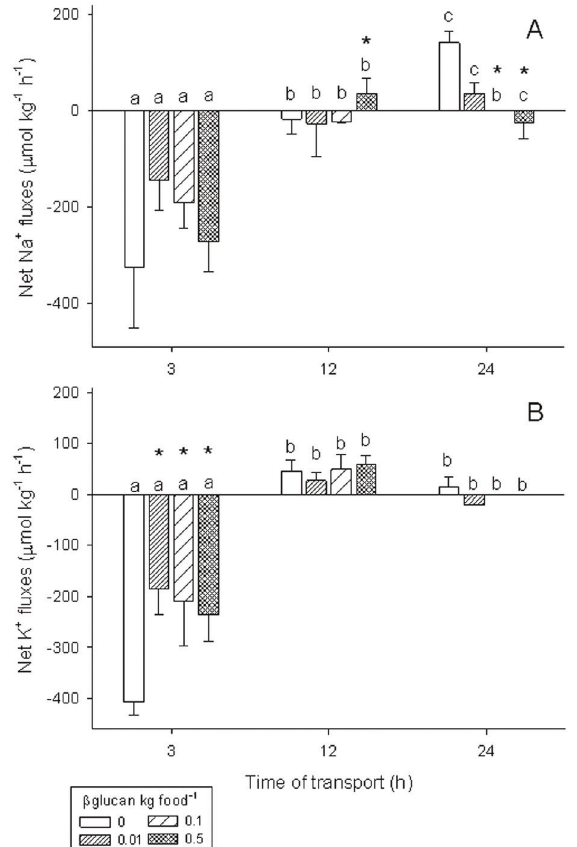
Fig. 2. Net Na+ (A) and K+ (B) fluxes during transportation of pencilfish ( Nannostomus trifasciatus ) previously fed with different levels of beta 1,3glucan. Positive values indicate net influxes and negative values net effluxes. N = 4 boxes per treatment in each sample time. Different lower case letters indicate significant difference among times of transport within the same group and * indicate significant difference from control group within the same time of transport by Scheirer-Ray-Hare extension of the Kruskal-Wallis test followed by the Nemenyi test